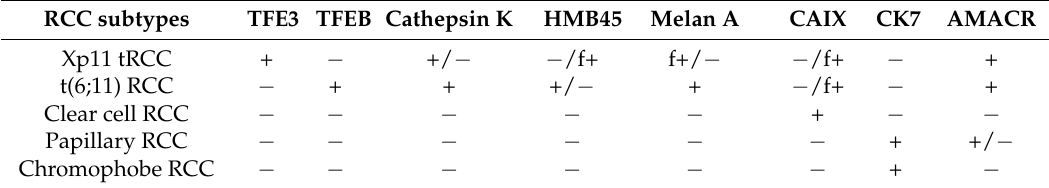
Table 1. Immunohistochemical panel for MiT family tRCC and common RCC subtypes. RCC